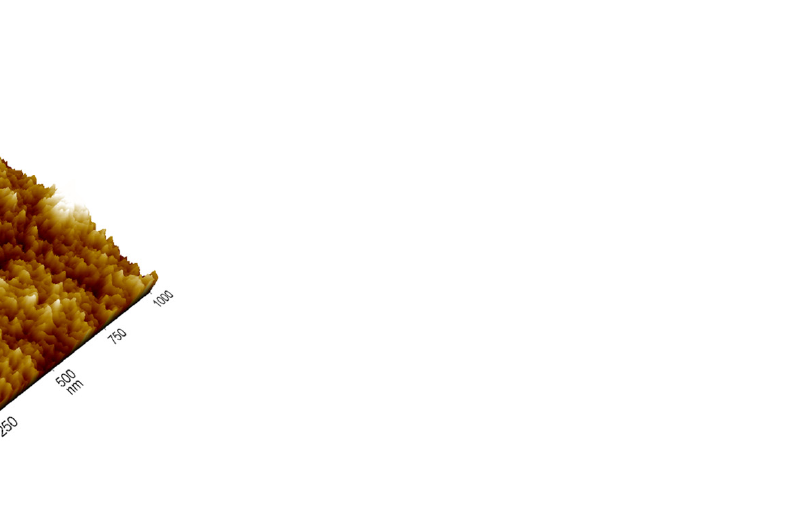
Figure 10. Three-dimensional AFM images of PEDOT: PSS without and with different organic additives and subjected to multi-FA treatment: ( a ) PEDOT: PSS, ( b ) PEDOT: PSS-maltitol (4 wt%), ( c ) PEDOT: PSS-sorbitol-maltitol (4 wt%; 3:1). Table 5. Transmittance, haze, sheet resistance, conductivity, and R q of PEDOT: PSS without and with different organic additives and subjected to multi-FA treatment.